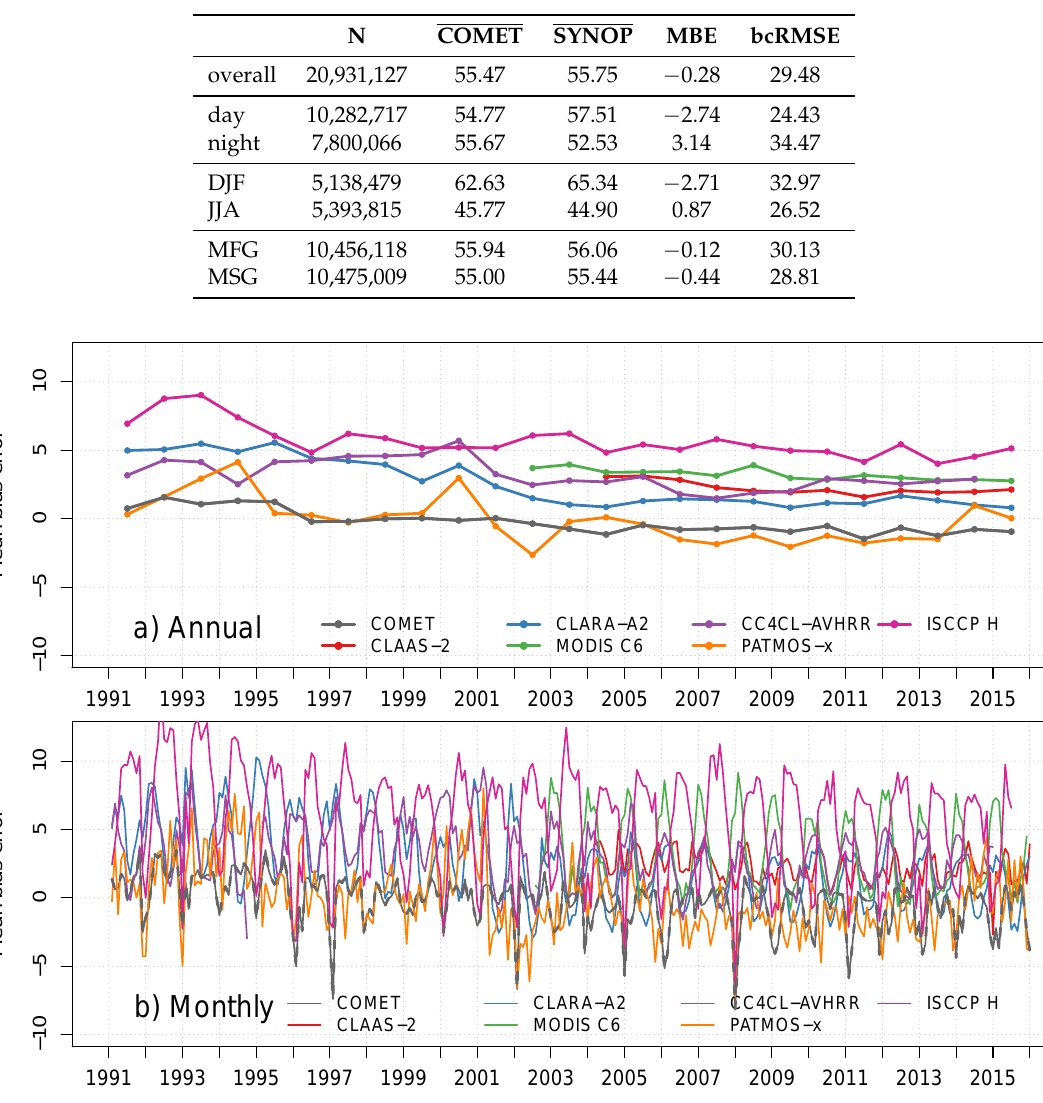
Table 2. Performance statistics of ClOud Fractional Cover dataset from METeosat First and Second Generation (COMET) CFC (%) compared with SYNOP at 237 sites based on instantaneous collocations. Number of collocations (N), mean COMET CFC (COMET), mean SYNOP CFC (SYNOP), Mean Bias Error (MBE) and bias-corrected RMSE (bcRMSE).